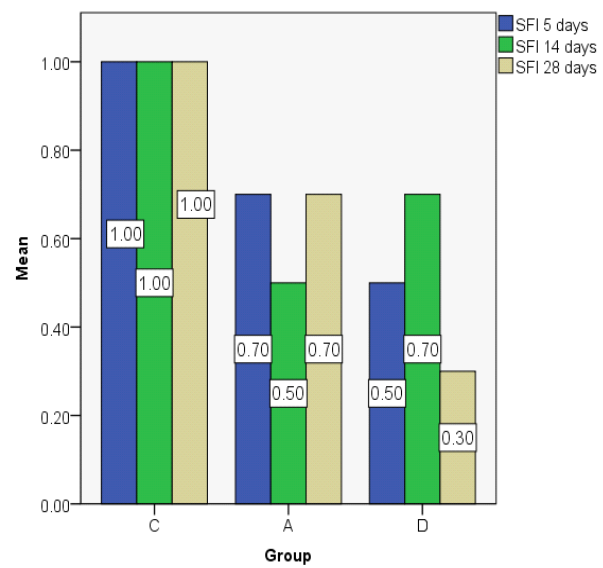
Figure 18. Subepithelial fibrosis index (SFI) value distribution expressed as the mean.